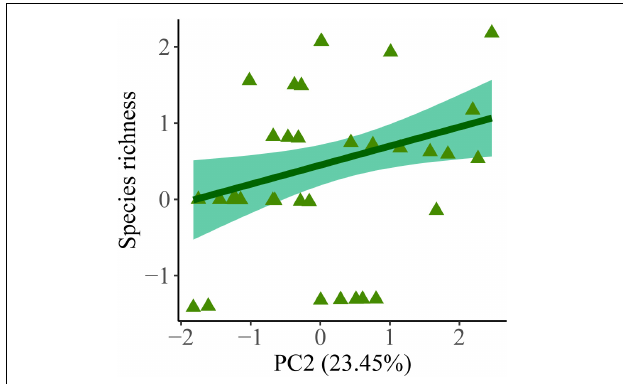
FIGURE 3 | Final regression model revealing the effect of habitat quality in small mammal estimated species richness (Chao 1) for forest specialists in semideciduous forest patches in the Brazilian Cerrado. PC2 corresponds to the second axis of a principal component analysis of six forest structure variables used to describe habitat quality.